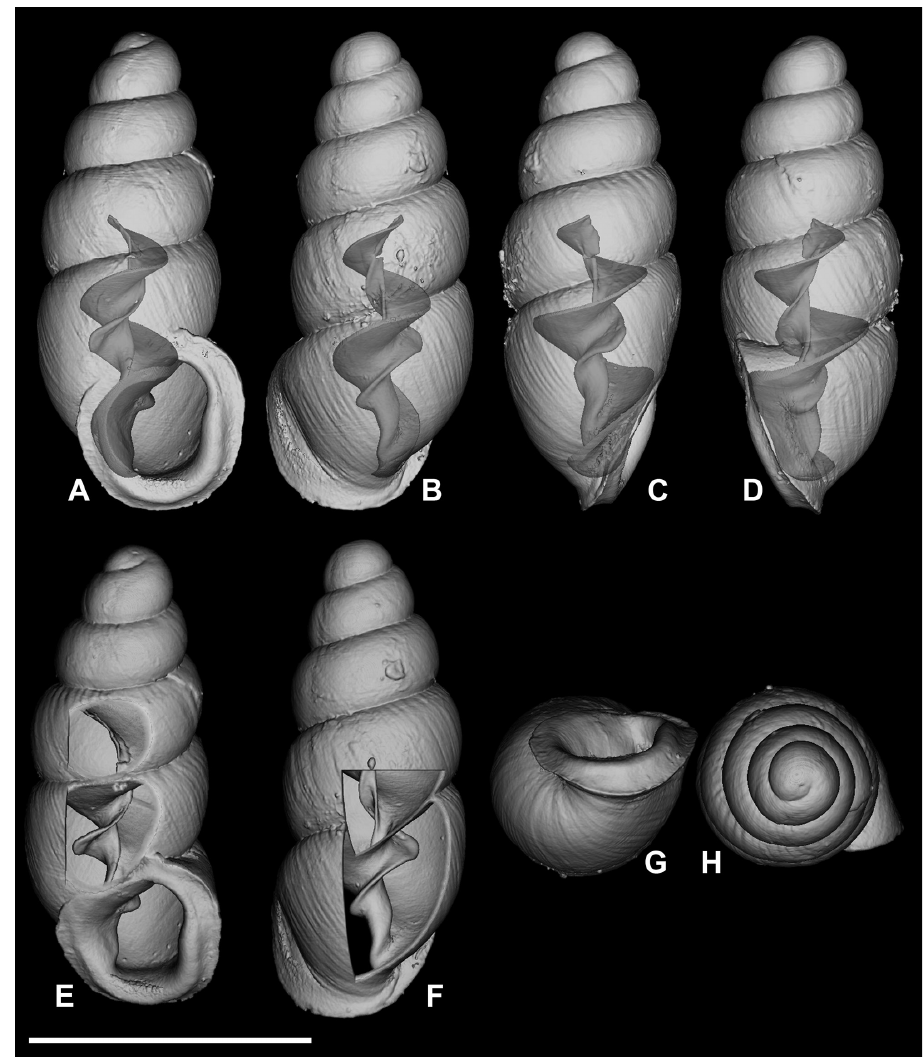
Figure 7. Comparative material, Carychium floridanum Clapp, 1918 (CM 46540). A–F CT scans show- ing columellar apparatus and simple lamellar sinuosity of syntype C moderately thickened S-shaped la- mella A, E zones of increased callus concentration on the peristome G umbilical view showing turned back rim of peristome. Scale bar 1